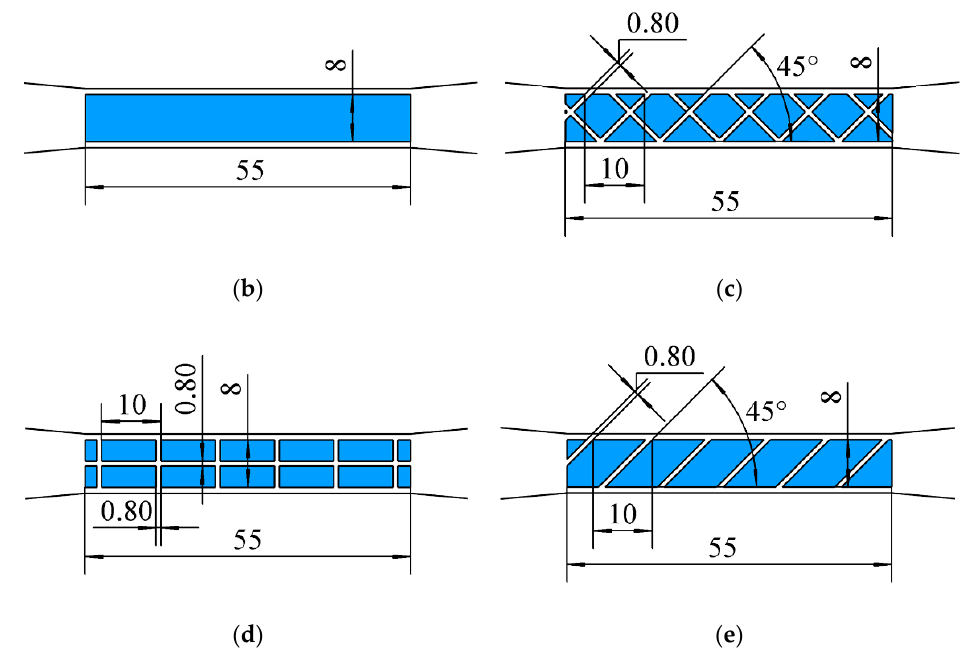
Figure 8. Geometric structure of the test sample. ( a ) Size of solid sample; ( b ) hollow; ( c ) slant cross; ( d ) cross; ( e ) slant.